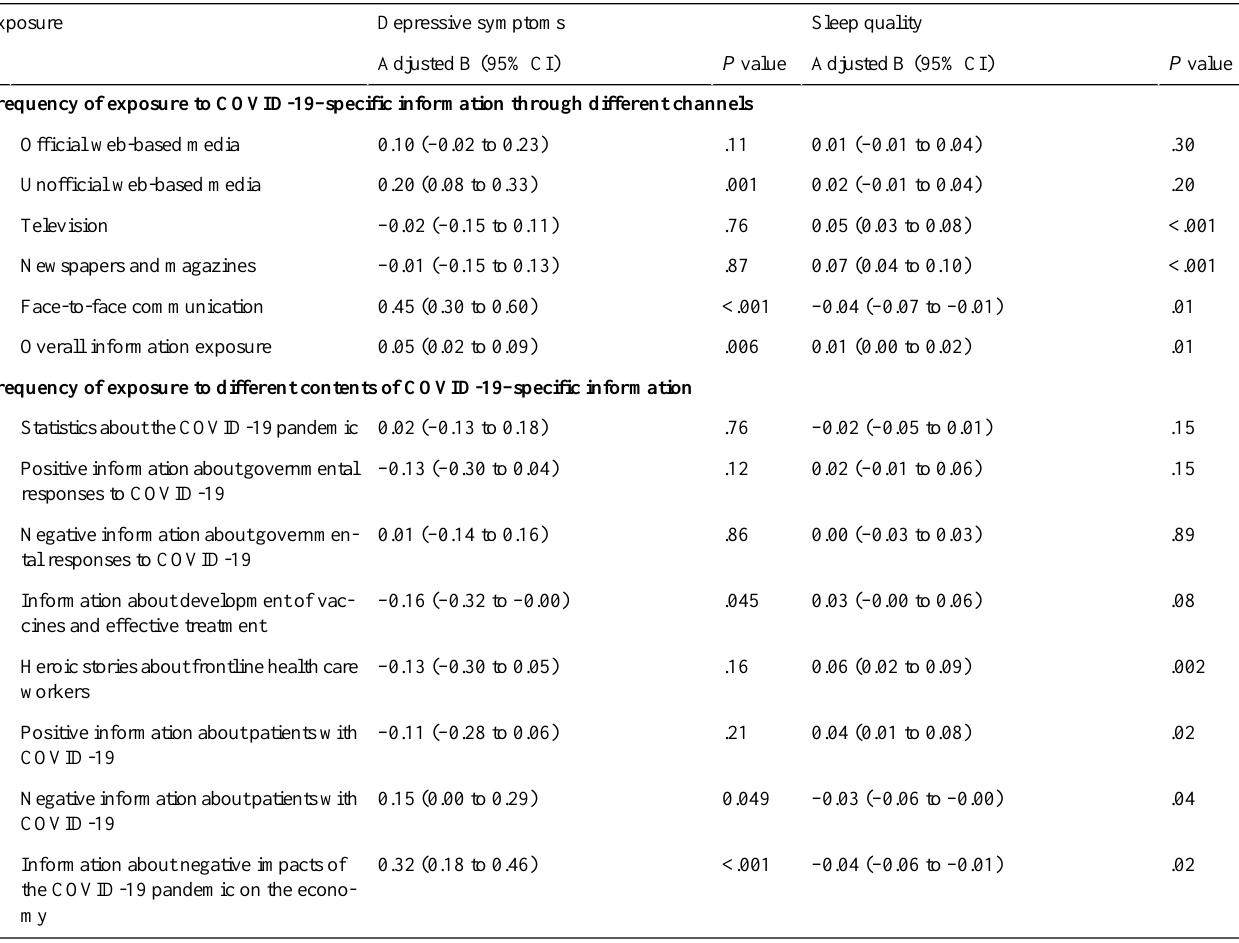
Table 4. Linear regression on exposure to COVID-19–specific information and mental health outcomes (N=3035).